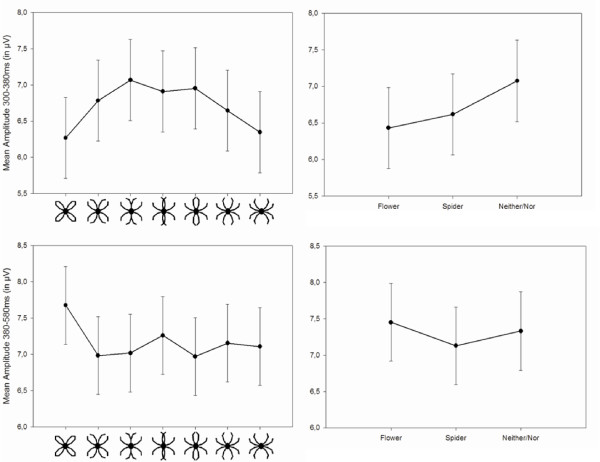
Stimulus and response dependent analysis of late ERPs. Mean amplitudes in the P3 (upper row) and P4 (lower row) latency range for stimulus (left) and response dependent analysis (right).